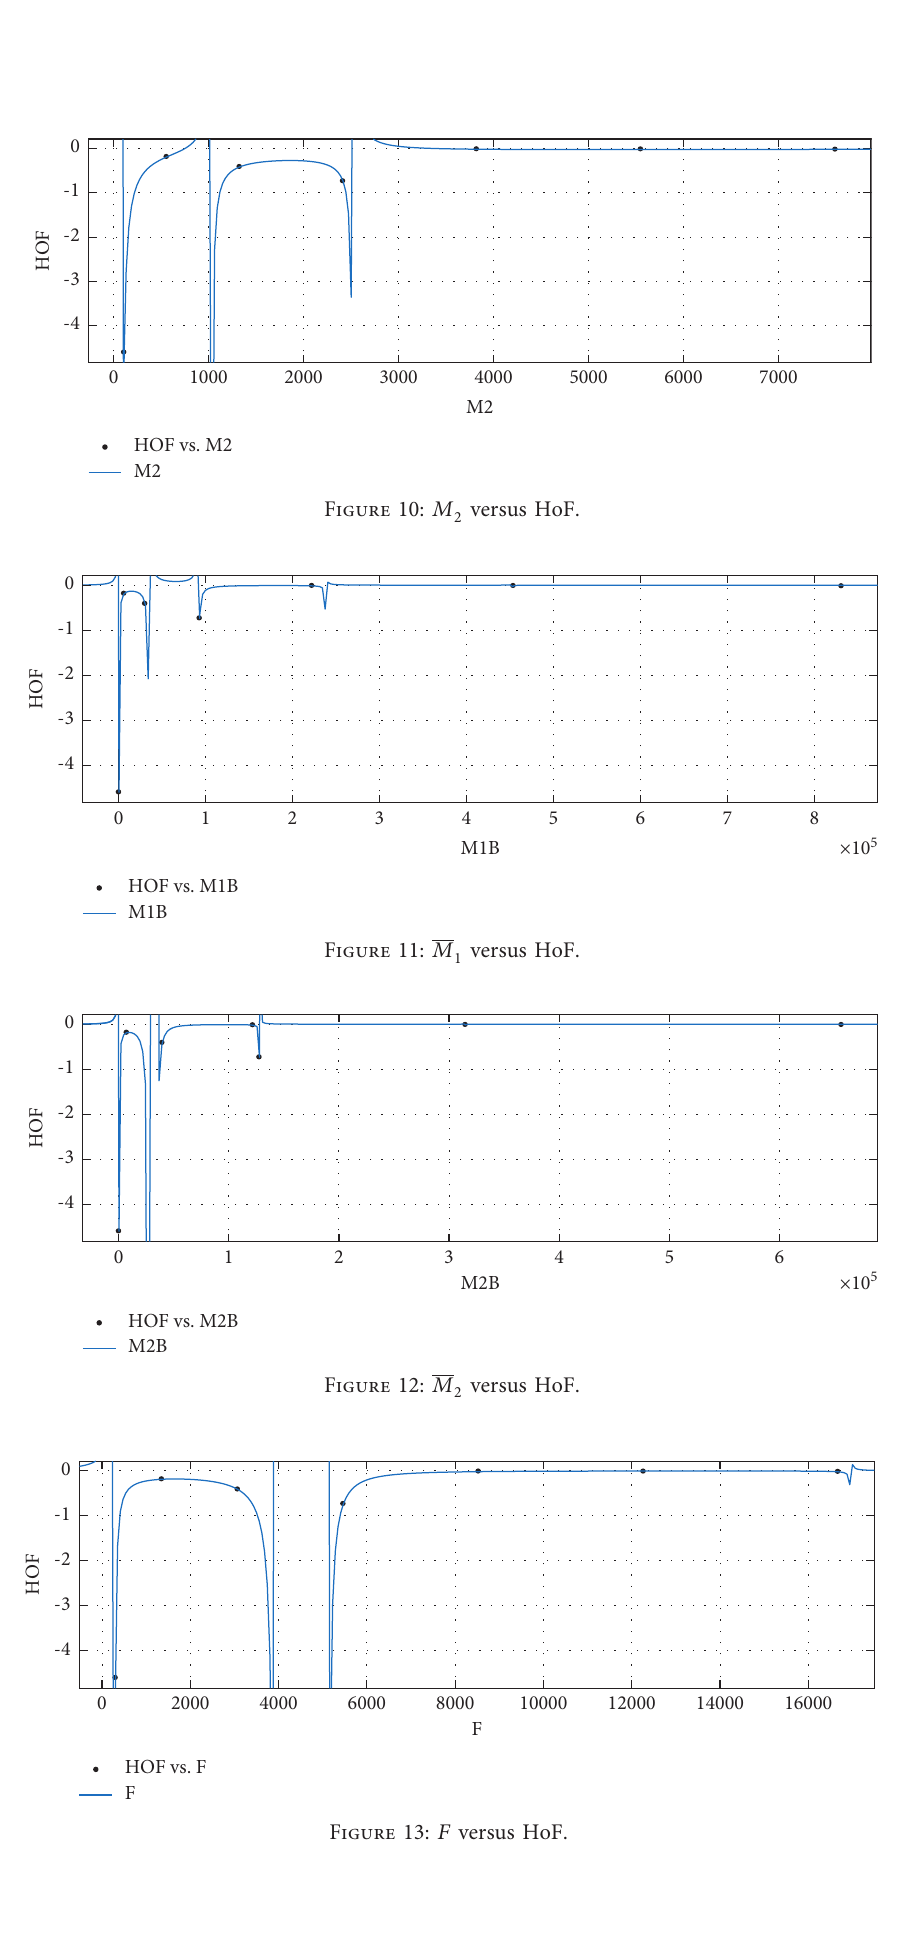
Figure 13: F versus